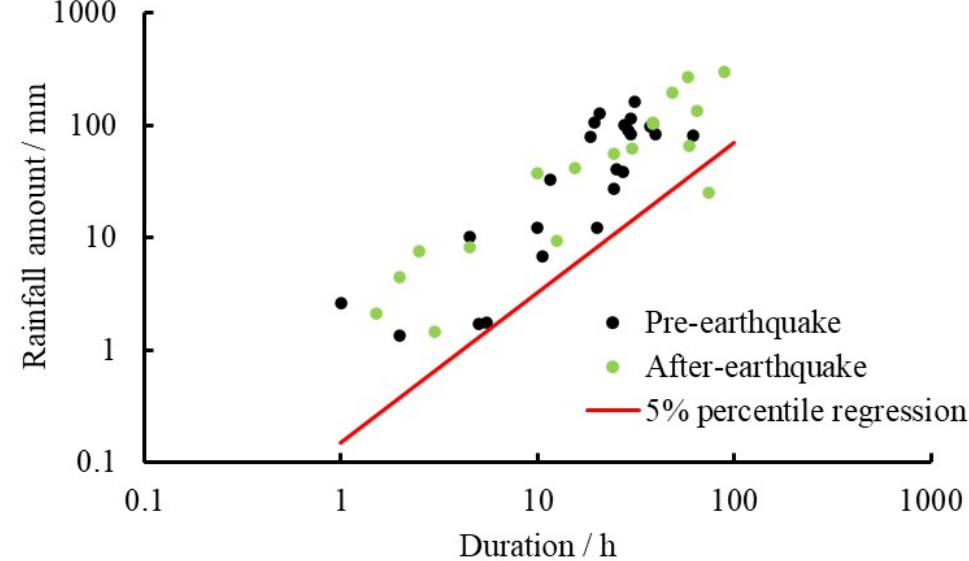
Figure 10. The rainfall threshold before and after the Wenchuan earthquake for landslides.